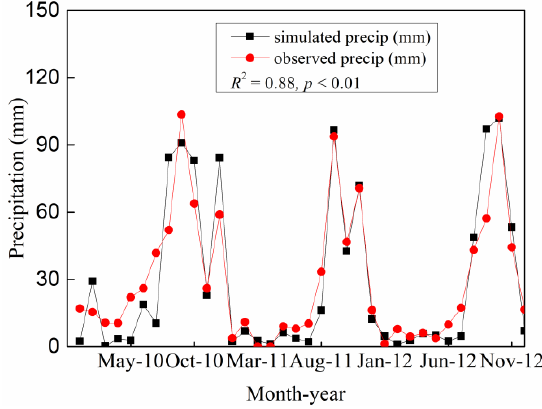
Figure 4. Simulated and observed monthly precipitation at AWS1 from 2010 to 2012.